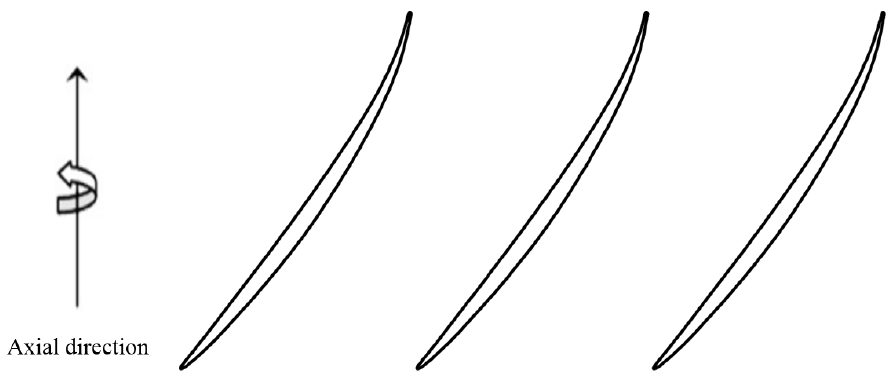
Figure 7. Geometric shapes of initial cascade